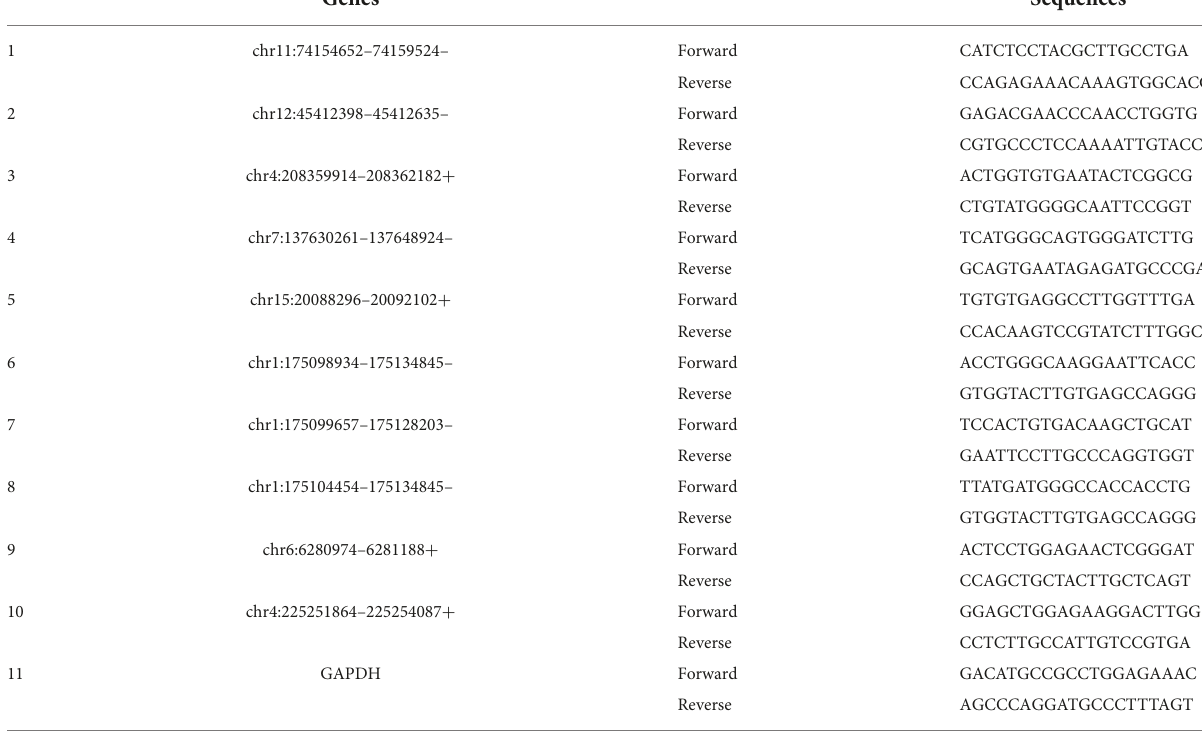
TABLE 1 The primer sequences for circular RNA (circRNA) identification.